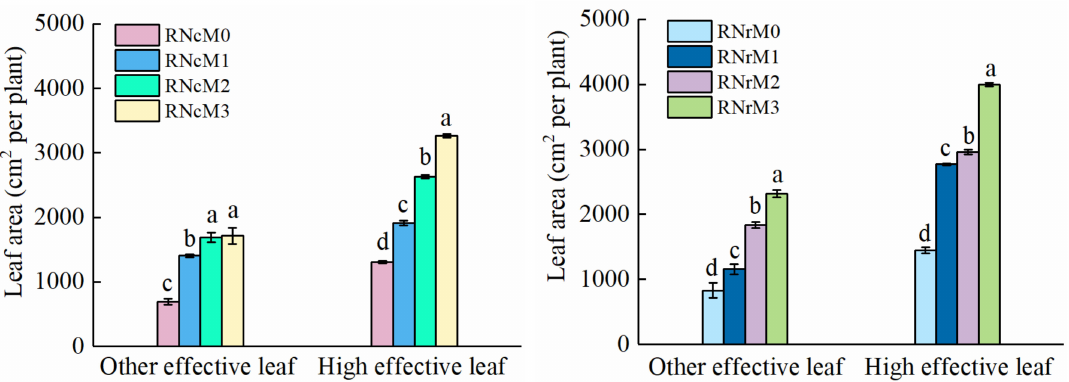
Figure 2. E ff ects of nitrogen fertilizer applications during the rapeseed season and nitrogen management during the rice season, on the leaf area of hybrid rice. R represents rapeseed; Nc and Nr represent the nitrogen fertilizer input of the rape season; M0, M1, M2 and M3 represent the nitrogen fertilizer operation in the rice season (0 kg N / hm 2 ) and conventional nitrogen application (150 kg N / hm 2 ), respectively . Lower case letters indicate that the photosynthetic characteristics of the hybrid rice are significantly di ff erent with the di ff erent treatments ( p < 0.05, LSD